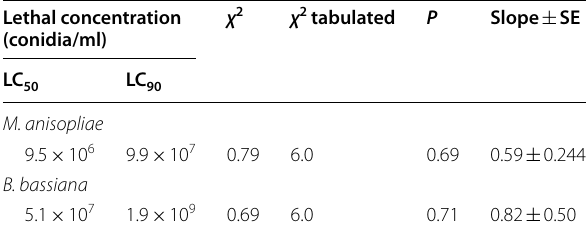
Table 1 Lethal concentration values of LC ml) of Metarhizium anisopliae and Beauveria bassiana for Bactrocera zonata fly at 72 h of treatments under laboratory